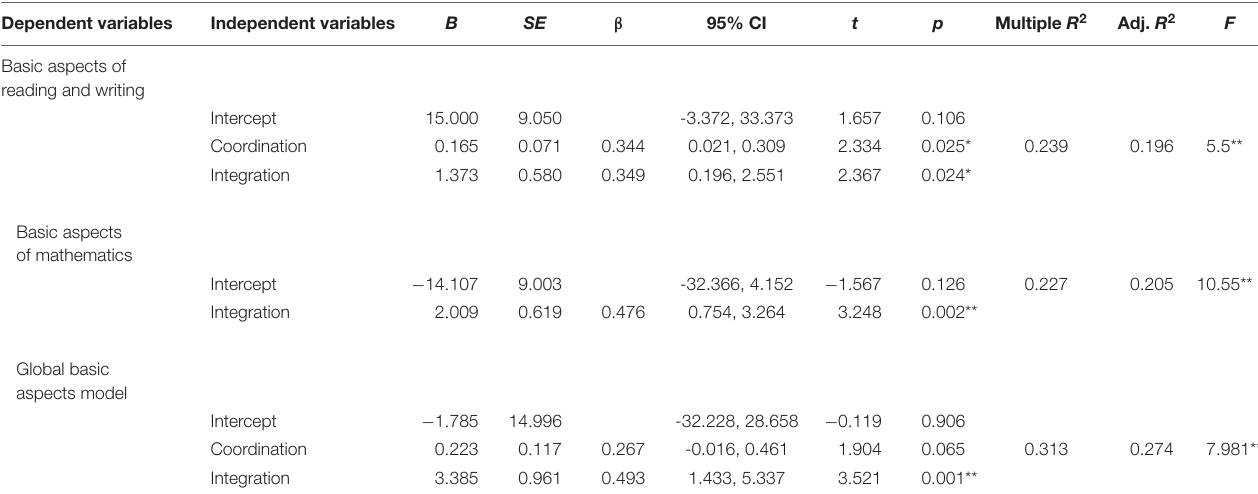
TABLE 3 | Summary of statistics of variables of each MLR model calculated. Dependent